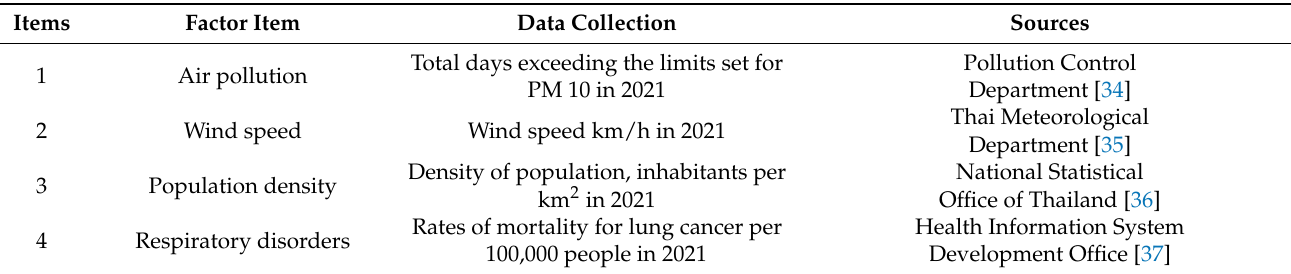
Table 1. Factors used for COVID-19 diffusion determination in an urban